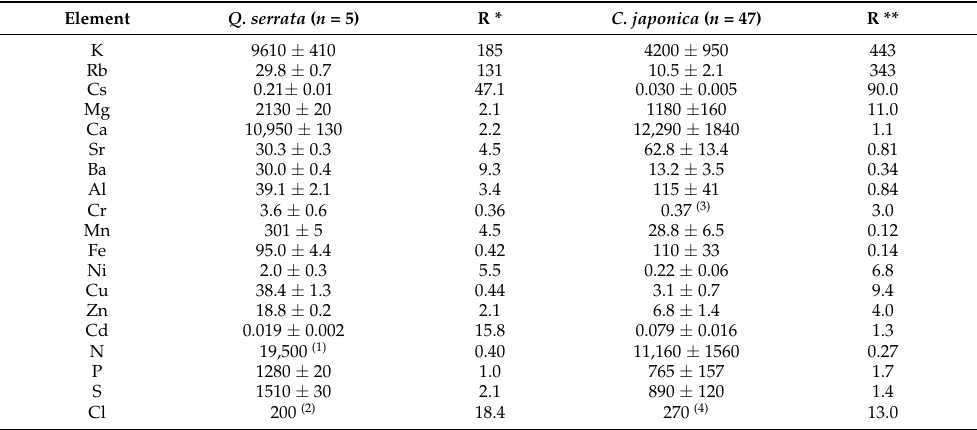
Table A2. Concentrations (ppm) of elements in the leaves of Q. serrata and C. japonica .